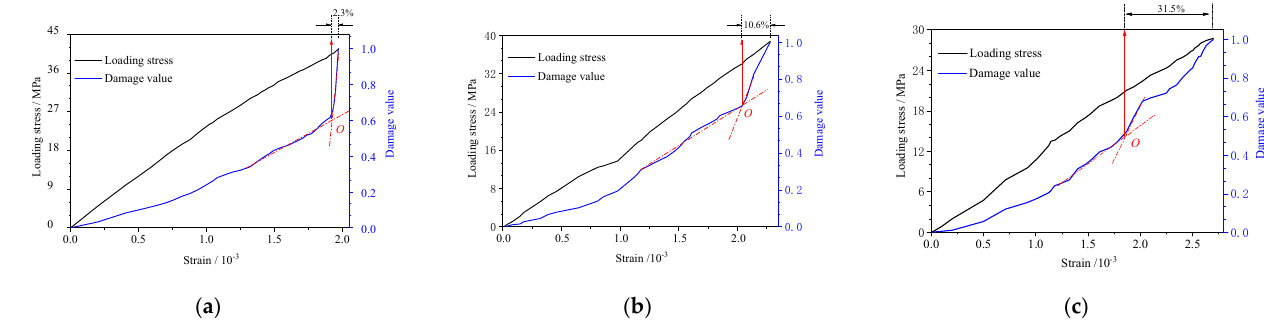
Figure 15. The curves of AE damage variable with strain under UCS test. ( a ) C1; ( b ) C2; ( c ) C3. It can be seen from Figure 15a, because of the low density of original defects, D- ε relation of C1 is almost linear before failure. At the beginning of loading, the damage value D slowly increases with the increasing stress as the original cracks and pores compacts. The damage value suddenly accelerates after strain has reached 97.7% of the peak strain (marked as O ). Afterwards, within only 2.3% of strain, the damage degree increased from 0.61 to 1.0, indicating typical brittle fracture behavior. As shown in Figure 15b,c, due to the initial defects caused by graphite powder [12], although a high damage value of con- crete occurs at low strain levels, the strain between turning point O and peak load in- creases to 10.6% and 31.5%; the deformation is larger in failure, and the D– ε curve has a more linear relationship, so that the damage form is changed from a brittle fracture to ductile fracture, and the failure of concrete under compression is more predictable. Figure 16 plots the curves of damage value D with crack mouth opening displace- ment CMOD for the specimens with different content of graphite powder under three- point bending test. The red chain-dotted lines are used to identify the turning points of damage value, named as P . Figure 16. The curve of damage variable with load under TPB tests. ( a ) B1; ( b ) B2; ( c )